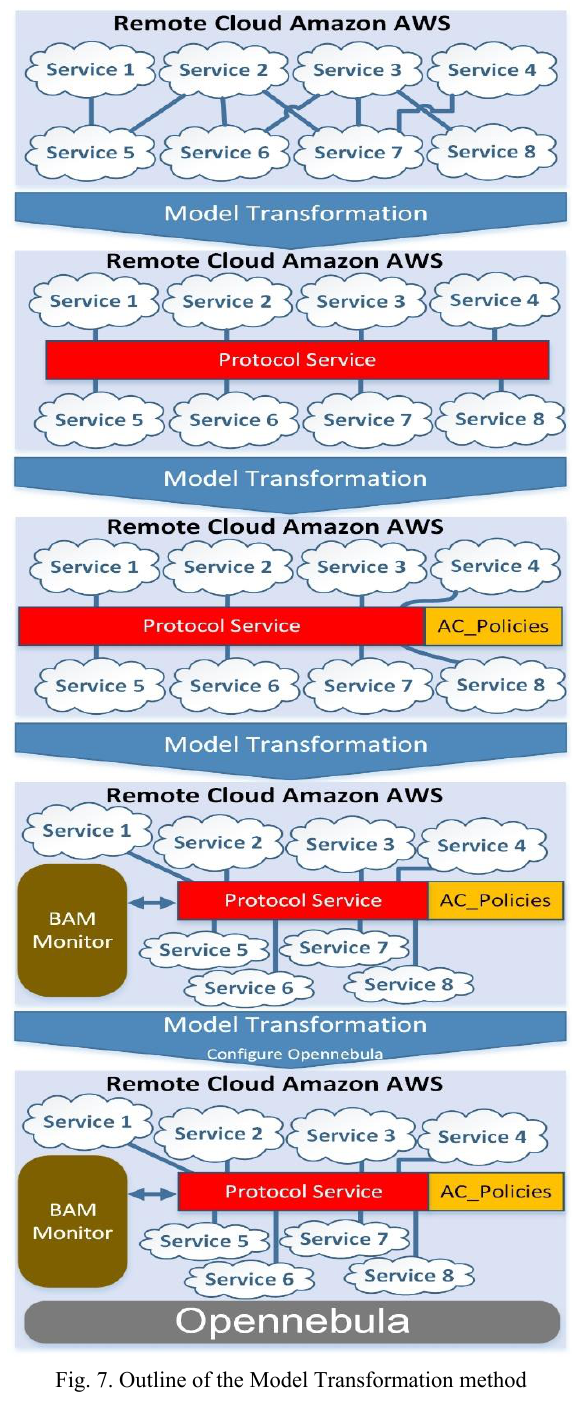
Fig. 7. Outline of the Model Transformation